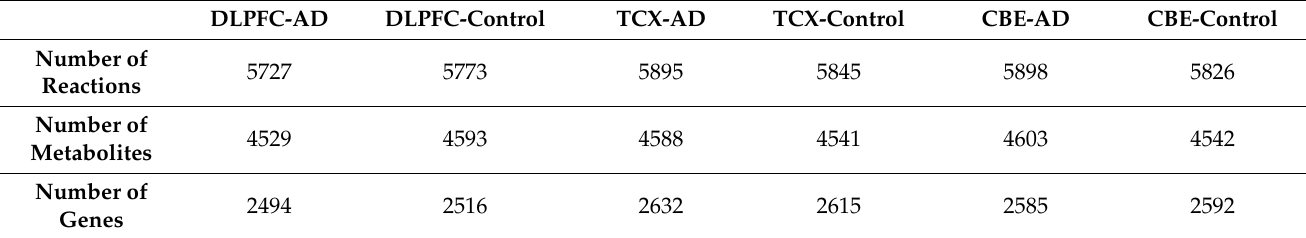
Table 5. Descriptive statistics of